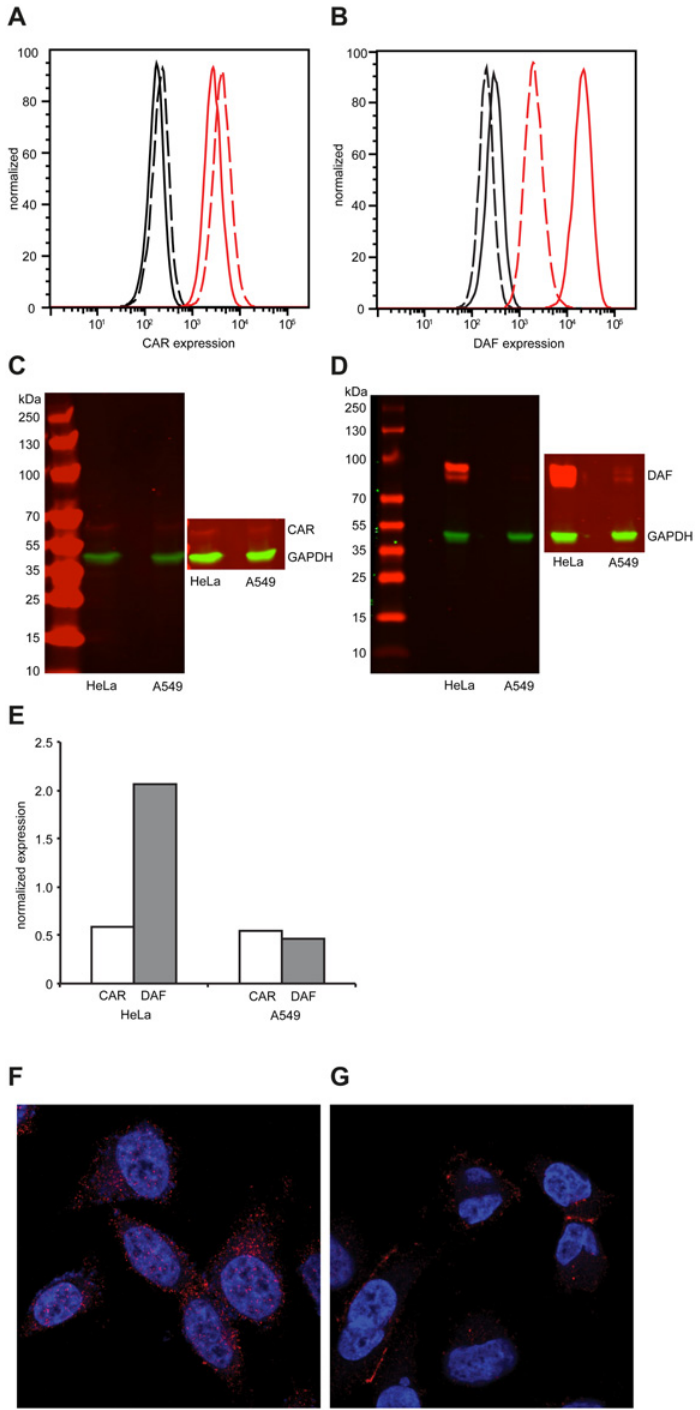
Fig 2. Differential expression of CAR and DAF in HeLa and A549 cells. (A-B) Expression of CAR (A) and DAF (B) by flow cytometry in HeLa cells (solid line) or A549 cells (dashed line). Fluorescence of cells in absence of antibody (black) or in presence of CAR- or DAF-specific antibody (red) is shown. Figures are representative of three independent experiments. (C-D) Expression of CAR (C) and DAF (D) by Western blot analysis of HeLa or A549 cell extracts, revealed by CAR-, DAF- and GAPDH-specific antibodies. Molecular weight markers are indicated on the left, super-exposed section of each figure is included to reveal the presence of CAR and the two isoforms of DAF in each sample. Figures are representative of two independent